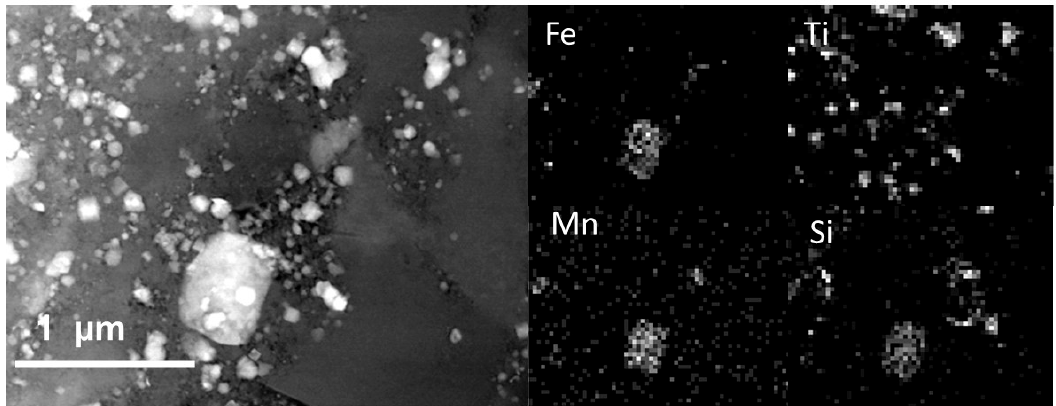
Figure 4. STEM image of the microstructure of AlMNC-T6 profiles and EDS elemental mapping analysis.